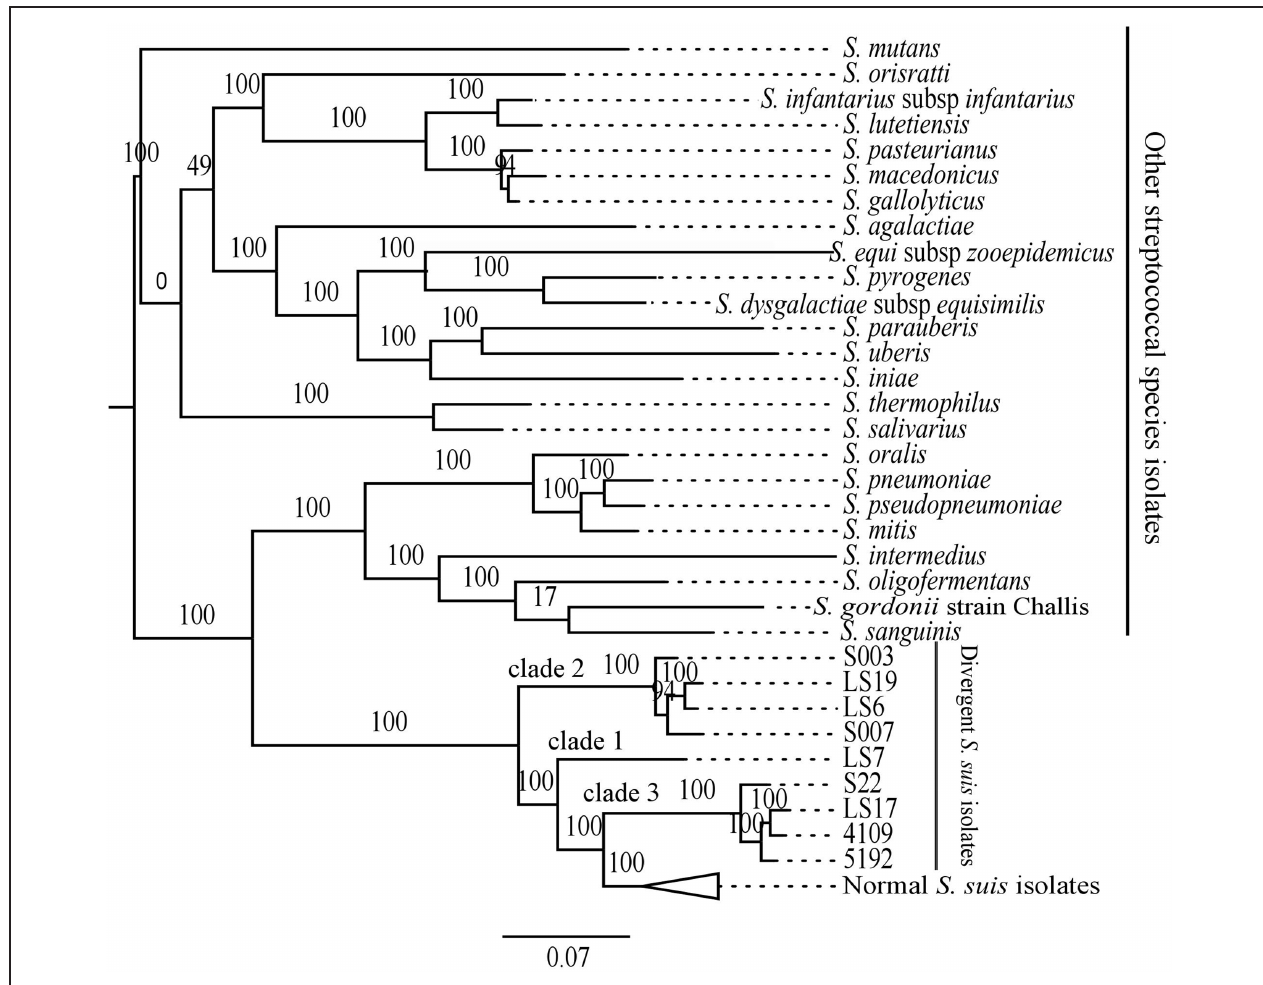
FIGURE 3 | Maximum likelihood phylogenetic comparison of the divergent isolates and representatives of the other 24 streptococcal species isolates, including 73 normal S. suis , based on shared subset of 132 genes. The branches with the normal S. suis isolates have been